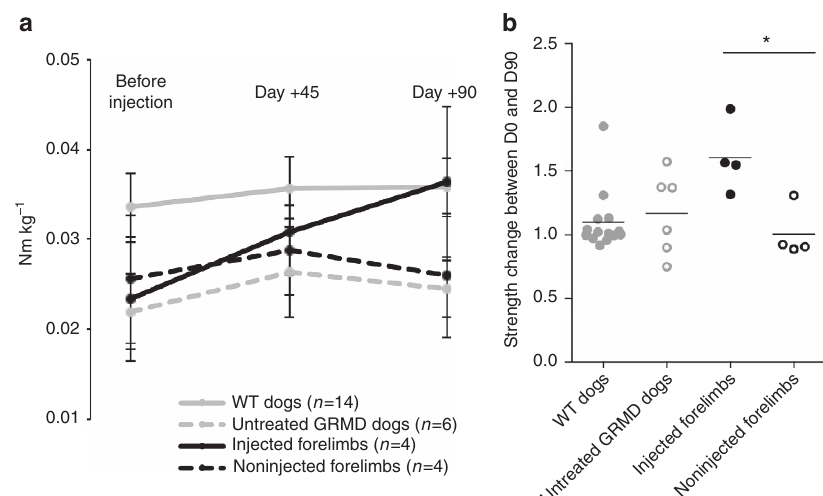
Figure 4 | Evolution of the extension strength of the wrist in the forelimbs of GRMD dogs injected with rAAV2/8-Spc5.12-cMD1 by the LR route. The extension strength of the wrist of the forelimbs was measured using a specific torque measurement device. Three measurement sessions were performed all along the protocol: before injection, at day þ 45 and at day þ 90. ( a ) The evolution of the maximal torques, normalized by the animal weight, over the three different measurement sessions, was represented on each panel. Each point represents the mean value ( ± 95% confidence interval) of the results obtained in forelimbs of healthy (WT) golden retriever dogs ( n ¼ 14, grey line), in forelimbs of untreated GRMD dogs ( n ¼ 6, grey dotted line), in the injected forelimb of rAAV2/8-Spc5.12-cMD1-treated GRMD dogs ( n ¼ 4, dark line) and in the noninjected forelimb of the same dogs ( n ¼ 4, dark dotted line). ( b ) Extension strength change between day 0 (before injection) and day þ 90. Each point represents the ratio between the maximal torque (normalized by the animal weight) obtained at day 0 and at day þ 90 in a same forelimb for healthy (WT) golden retriever dogs ( n ¼ 14, grey full symbols), in untreated GRMD dogs ( n ¼ 6, grey empty line), in the injected forelimb of rAAV2/8-Spc5.12-cMD1-treated GRMD dogs ( n ¼ 4, black full symbols) and in the noninjected forelimb of the same dogs ( n ¼ 4, black empty symbols). The horizontal bars represent the mean of the values obtained for each group. * P o 0.05 (nonparametric Kruskal–Wallis test with post hoc multiple comparison Dunn’s